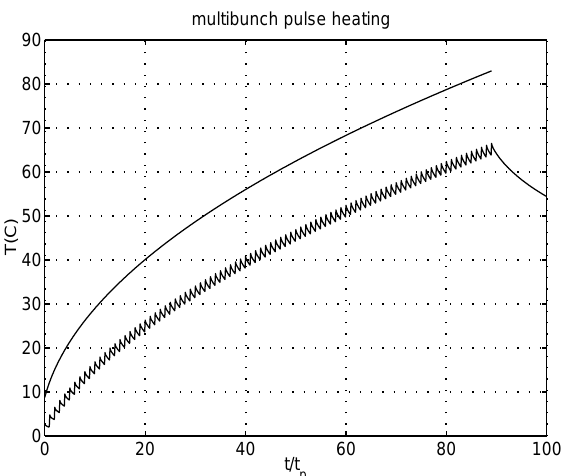
FIG. 9. Multibunch electron bunch heating for N p (cid:1) 90 . The smooth approximation is from Eq. (32). The result, plotted in Fig. 9, gives T max about 20% lower than the simple estimation from Eq. (32).